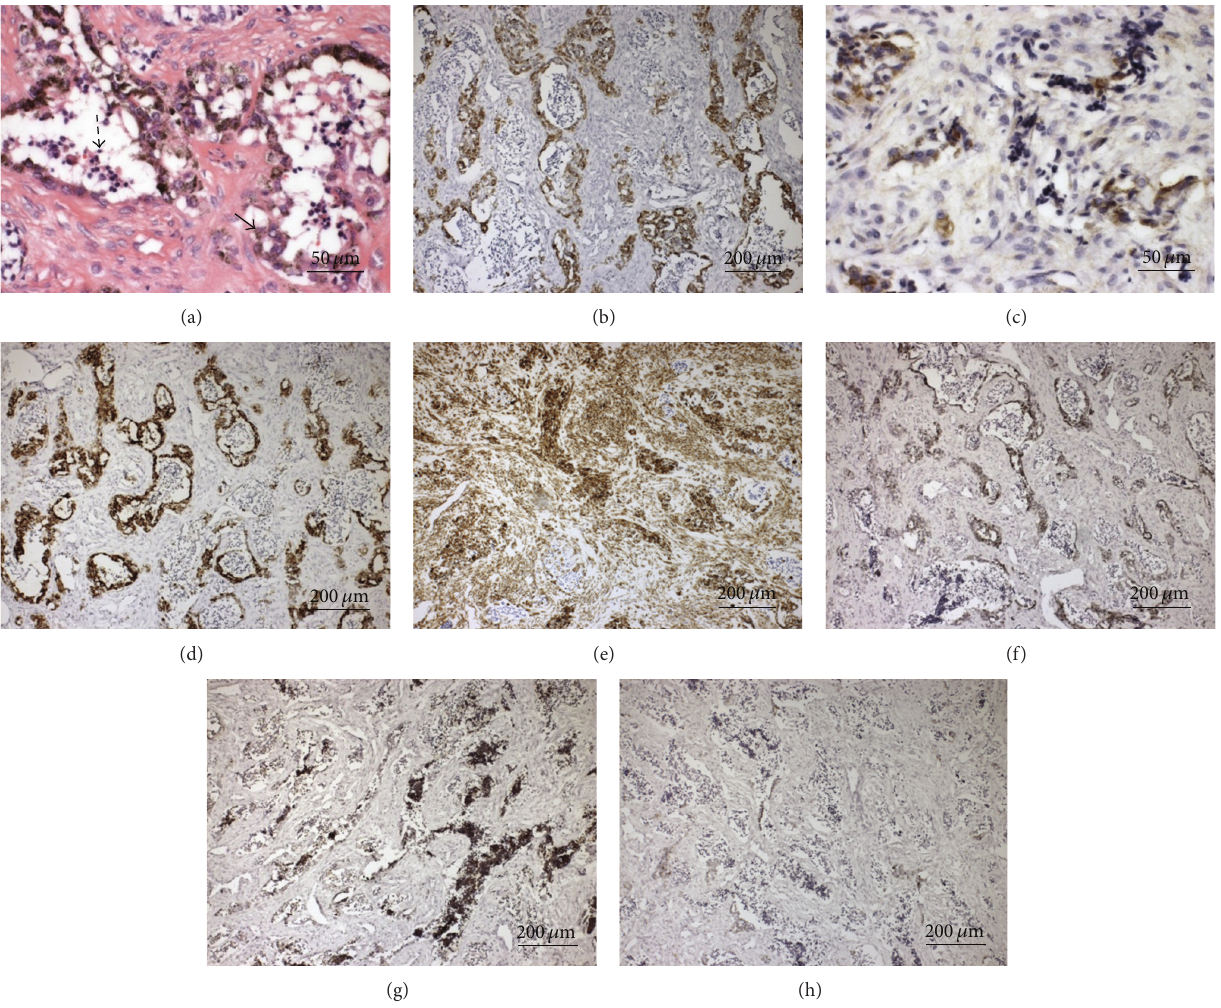
Figure 2: Photomicrographs of histological and immunohistochemical findings. Nests containing biphasic cell populations within dense connective tissue are shown. The presence of small neuroblast-like cells with delicate fibrils between them (indicated by dashed arrows) and large melanin-containing cells (indicated by arrows) were observed (H&E, magnification × 400) (a). Large epithelial-like cells were positive for cytokeratin AE1/AE2 (b) (magnification × 100), epithelial membrane—EMA (c) (magnification × 400), and HMB45 (d) (magnification × 100). Both cell types were positive for vimentin, but the signal intensity was stronger in large cells (e). Both cell types were also positive for chromogranin, but the signal intensity was stronger in small cells (f) (magnification × 100). Synaptophysin was expressed by small neuroblast- like cells (magnification × 100) (g). Nuclear expression of Ki67 was also observed (magnification × 100)